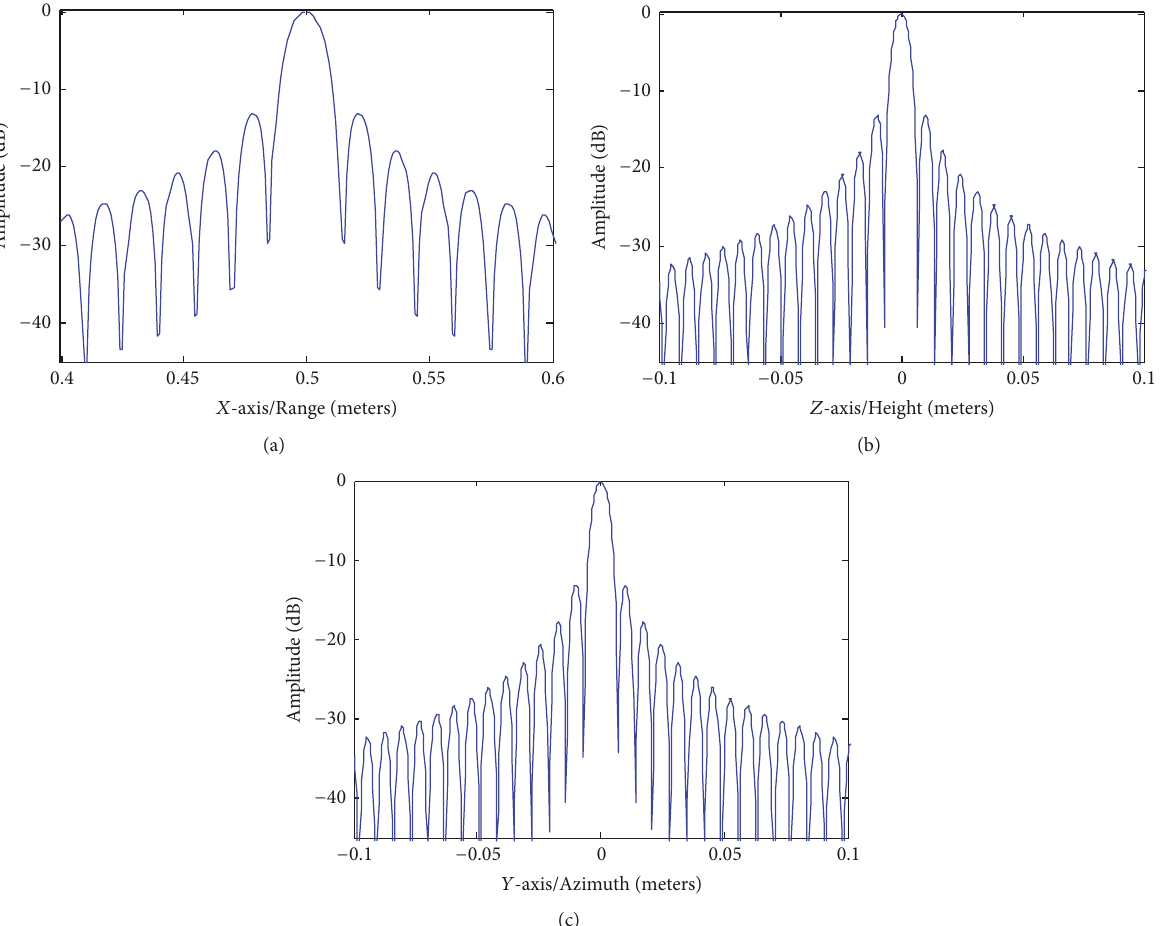
Figure 6: (a) Range, (b) azimuth, and (c) height profiles of the reconstructed target impulse response.